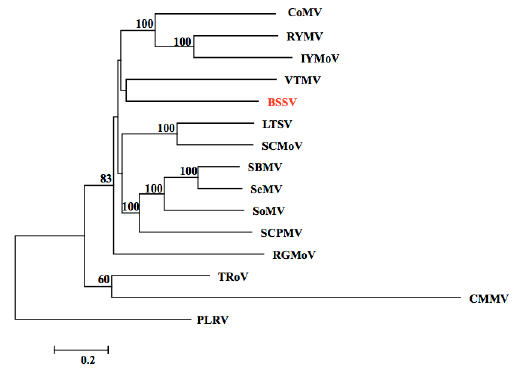
Figure 2. A phylogenetic dendrogram based upon alignments of the full-length genome sequence of Blueberry shoestring virus (BSSV) and the known viruses of the genus Sobemovirus . The viruses